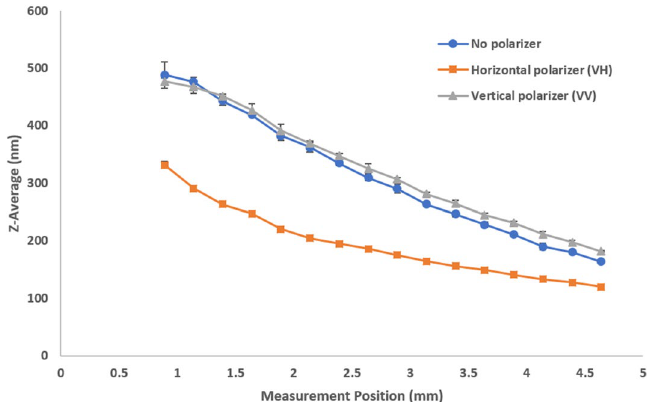
Figure 5. Size (z-average diameter) as a function of measurement position shows the effects of multiple scattering with different polarizer configurations for stock milk. The significance and influence of multiple scattering increases further into the sample, away from the cuvette